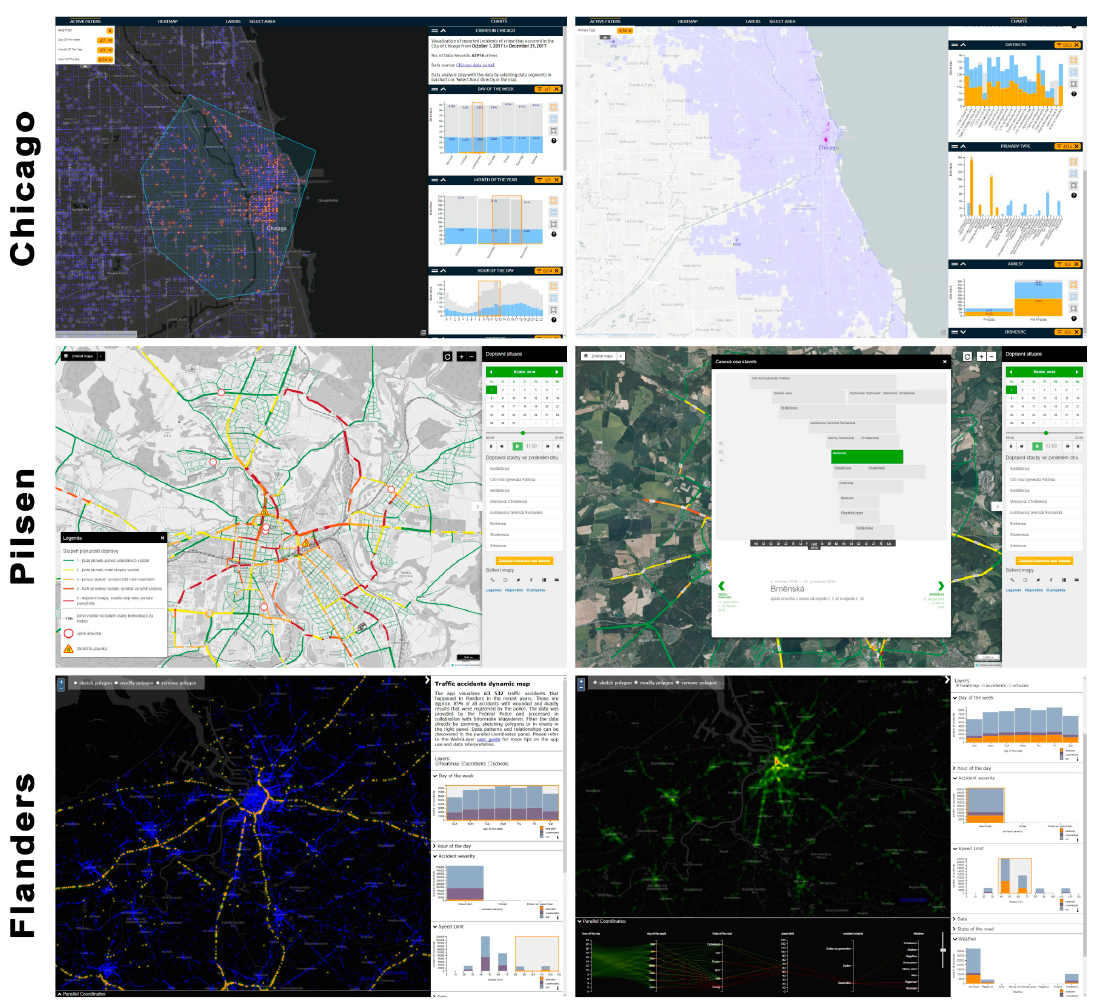
Figure 2. Stimuli from the static part of the experiment.